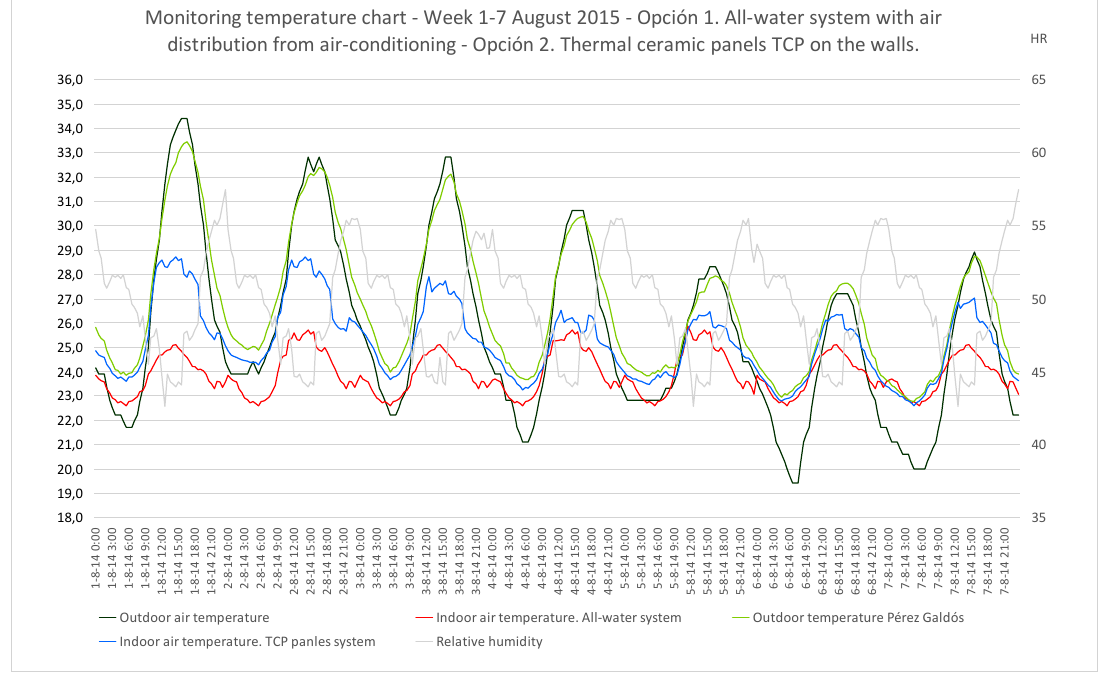
Monitoring temperature chart - Week 1-7 August 2015 - Opción 1. All-water system with air distribution from air-conditioning - Opción 2. Thermal ceramic panels TCP on the walls.